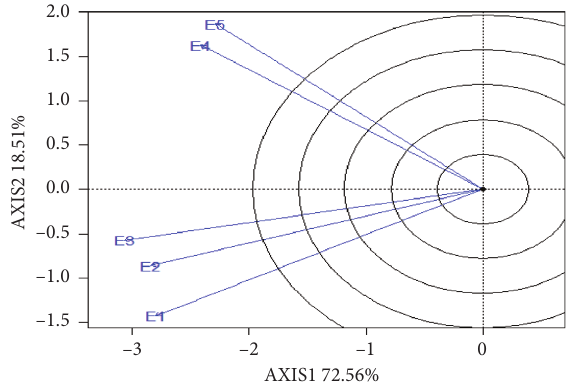
Figure 2: Relationship of test environment for tube yield across five environments. The biplot based on scaling by standard deviation; centering � 2; SVP � 2; genotypes: G1 � 95/0194, G2 � 95/18544, G3 � 95/18922, G4 � 95/18949, G5 � 95/19156, G6 � 95/19158,